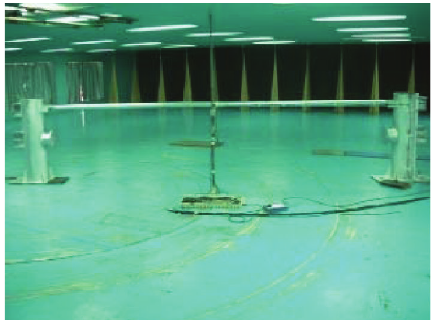
Figure 7: View of wind tunnel testing of the vortex-induced vibration.